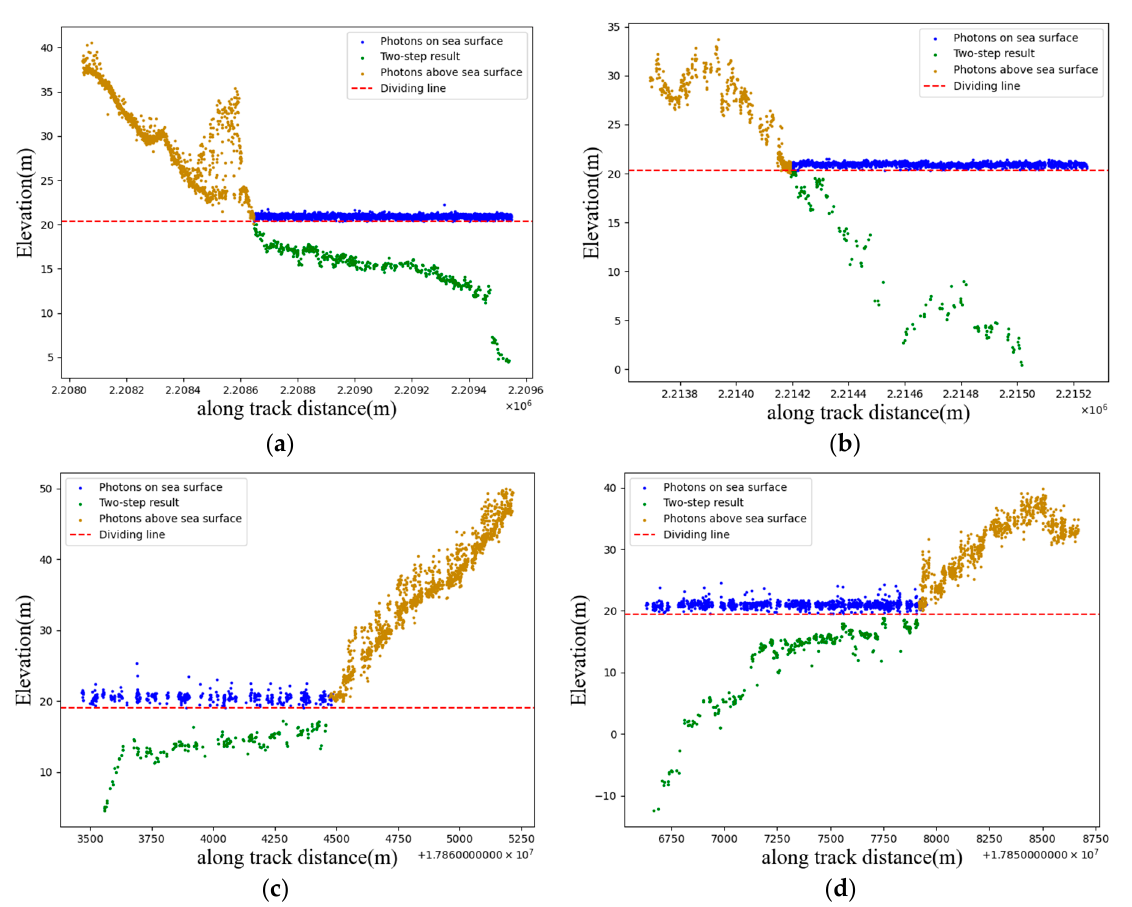
Figure 9. ( a ) The two-step method denoised 480 orbit gt1r beam; ( b ) the two-step method denoised 480 orbit gt2r beam; ( c ) the two-step method denoised 1036 orbit gt2r beam; ( d ) the two-step method denoised 1036 orbit gt1r beam.